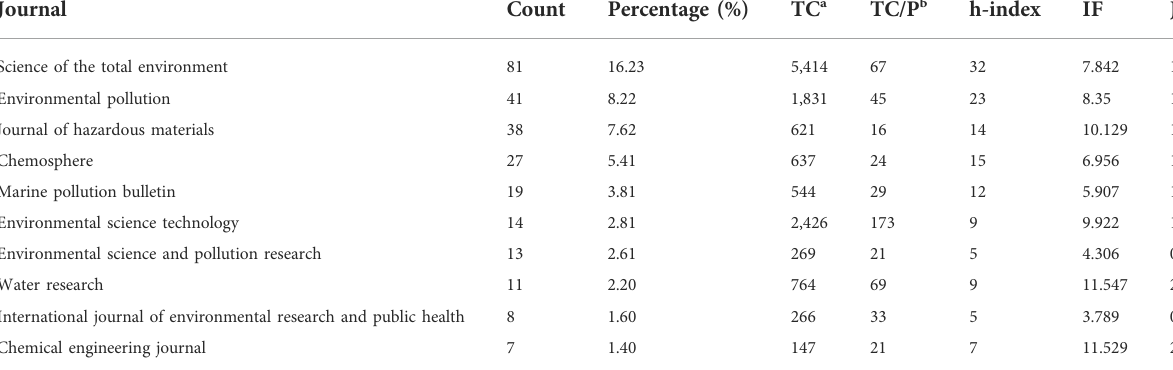
TABLE 3 Top ten journals with publication